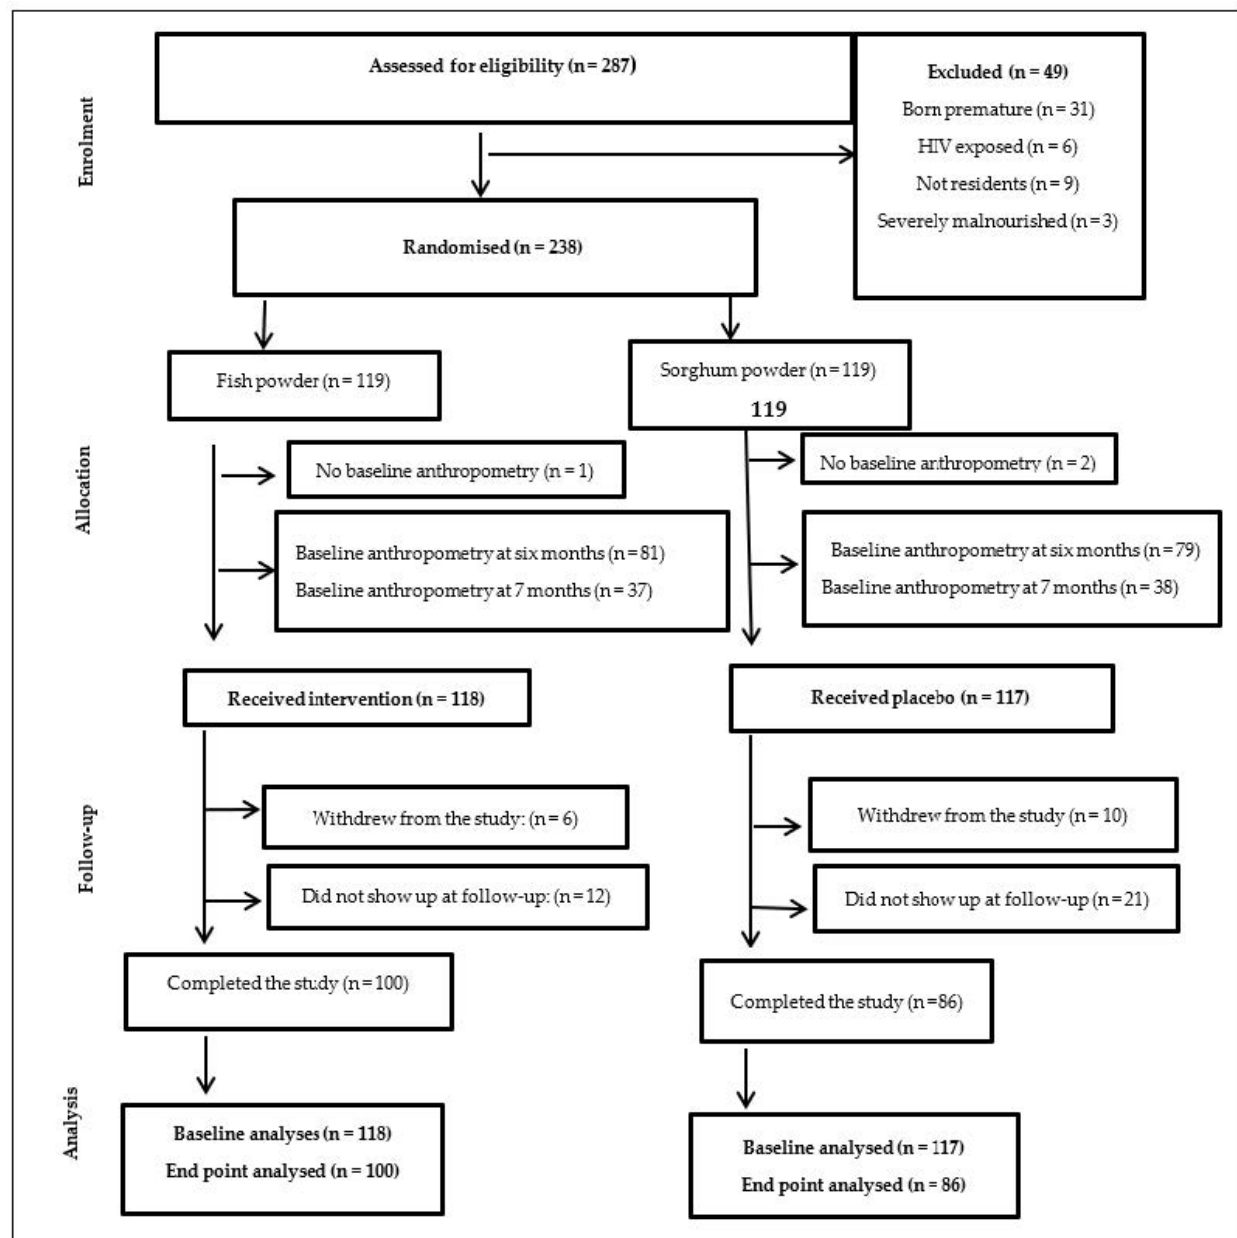
Figure 1. Flow of the study participants.